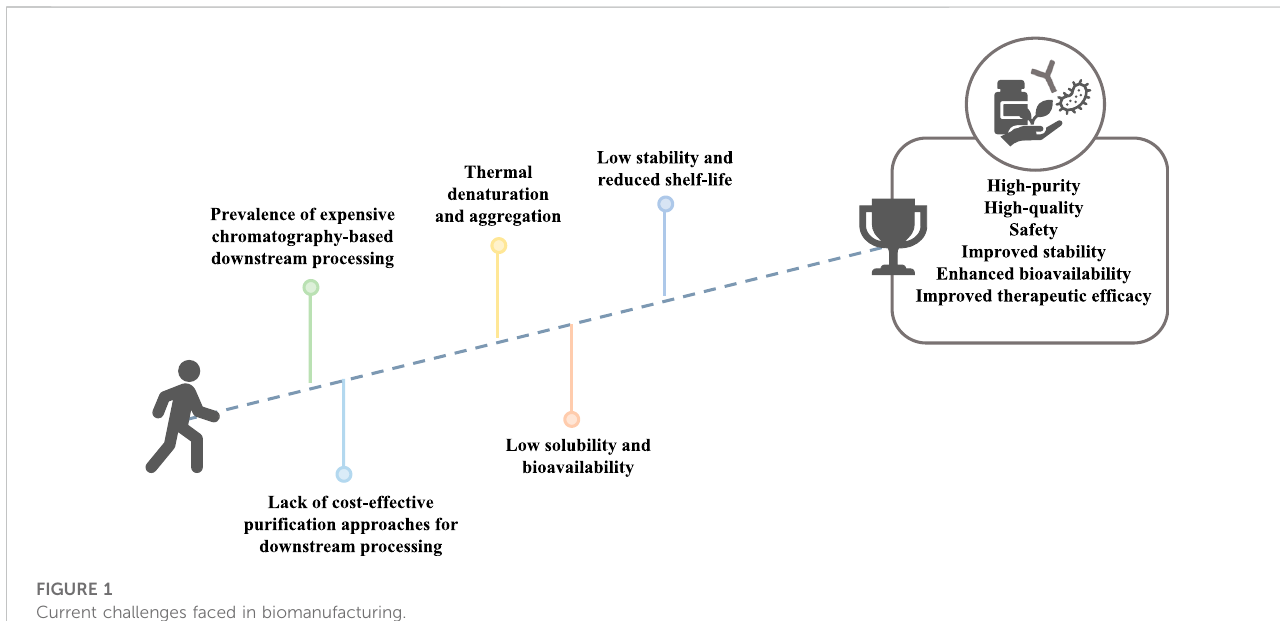
FIGURE 1 Current challenges faced in